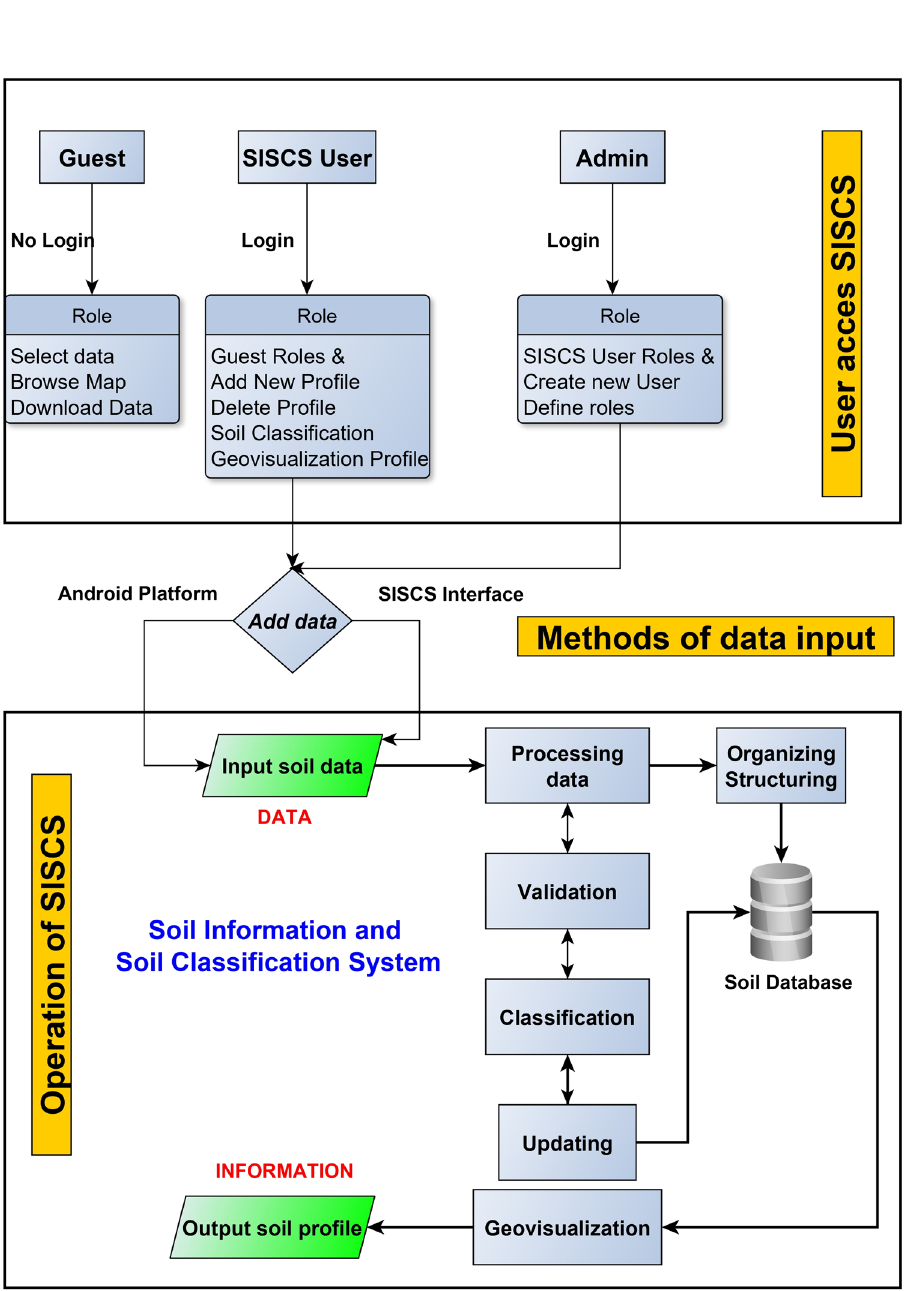
Figure 5: Structure and operation of SISCS ( source: Balla et al. 2016 – fi gure expanded )